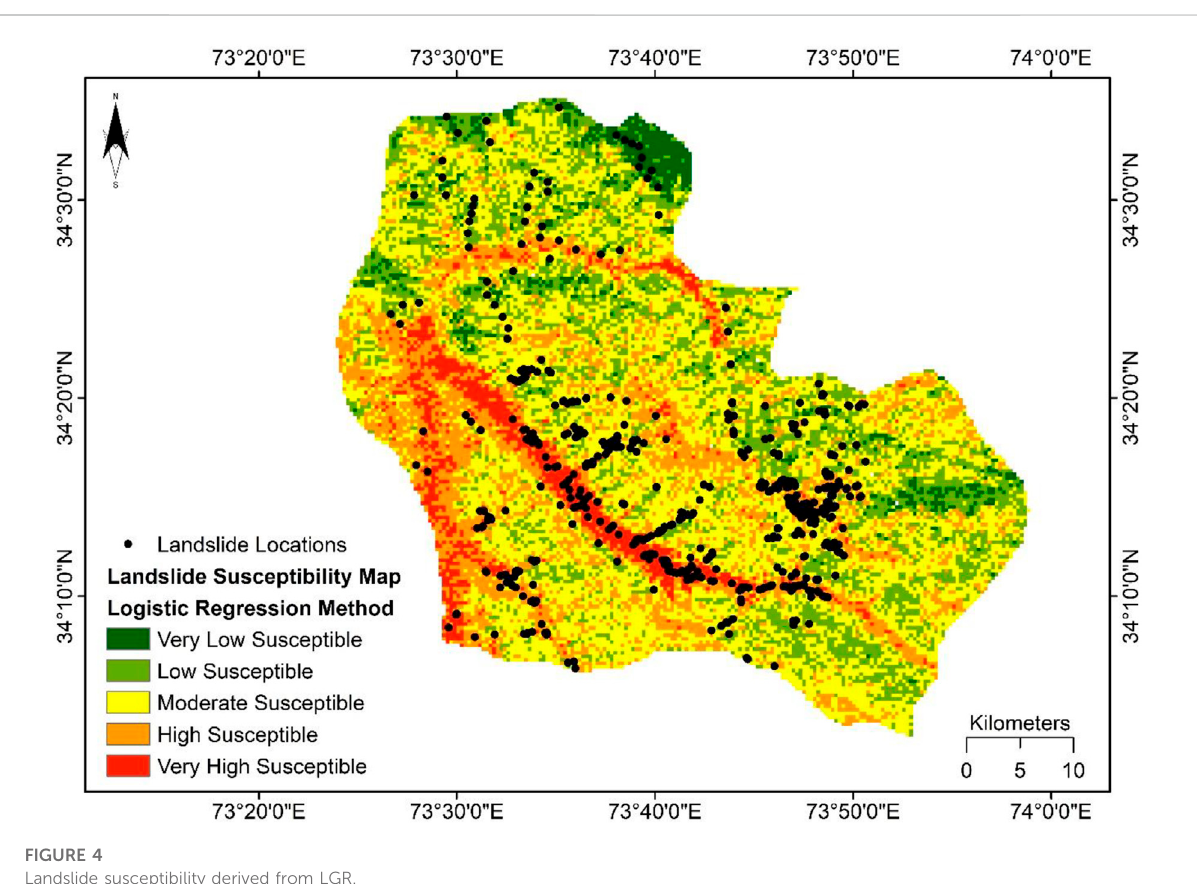
FIGURE 4 Landslide susceptibility derived from LGR.